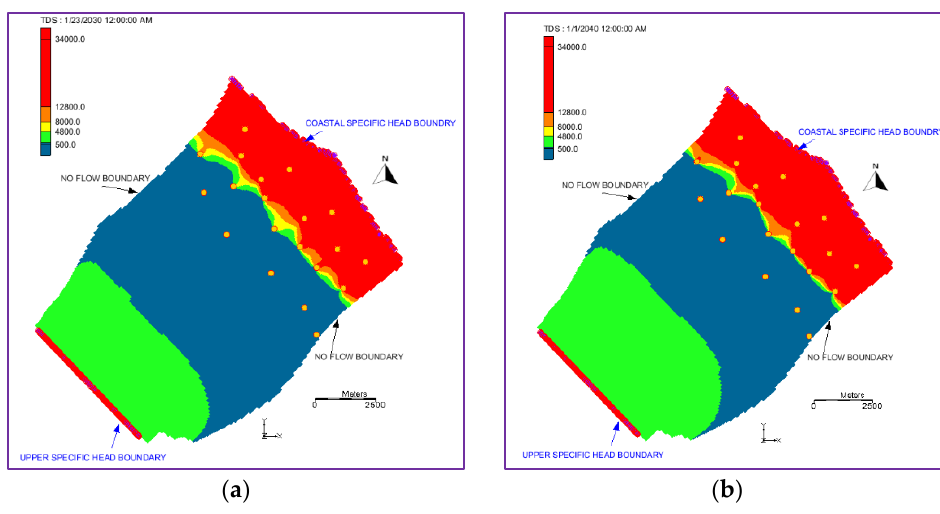
Figure 6. Salinity contours for Scenario-1 pumping rates from 2017: ( a ) 2030 and ( b ) 2040.